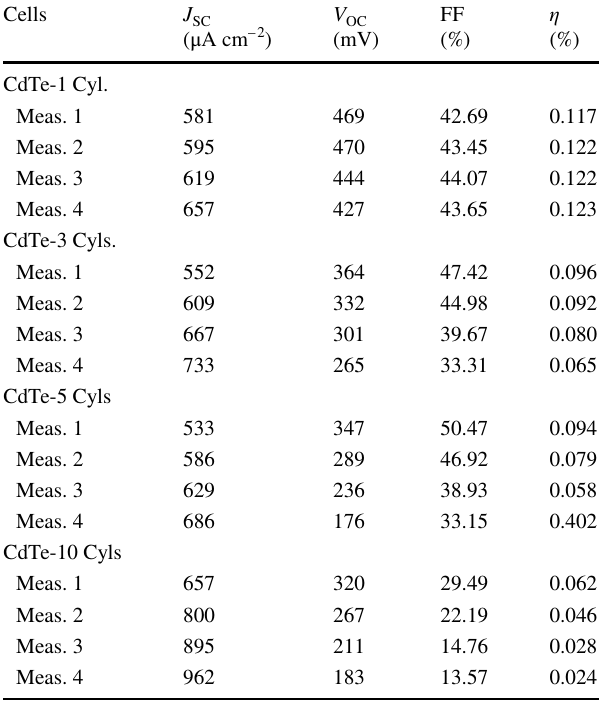
Table 1 Photovoltaic parameters of solar cells used CdTe of 1, 3, 5, and 10 SPD cycles coated on TiO 2